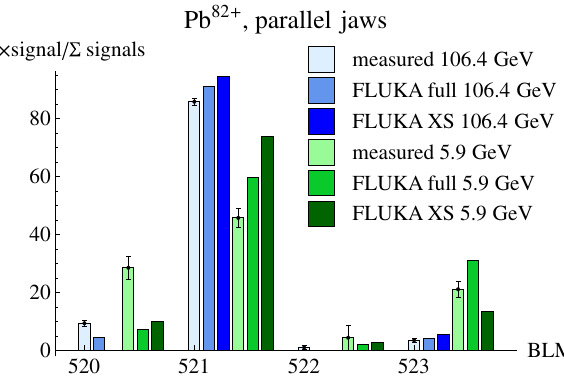
FIG. 19. (Color) The simulated distribution of (cid:8) calculated according to Eq. (3) from the FLUKA full method of all ion fragments except 208 Pb 82 þ coming out of the collimator at 5 : 9 GeV = nucleon . The heights of the bars show the number of nucleons belonging to ions having (cid:8) within a certain interval.